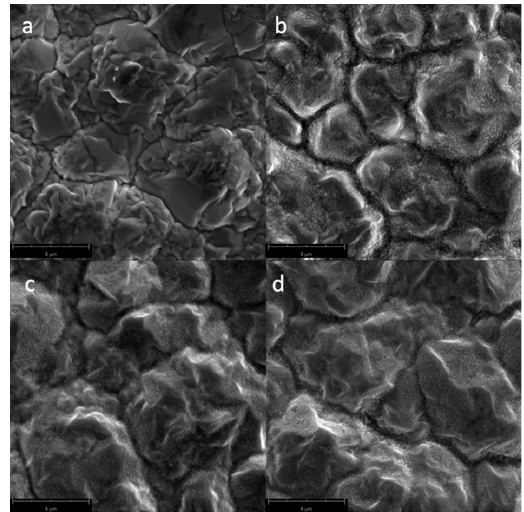
Figure 4. SEM micrographs of the surfaces of the Cu samples (magnified at 10,000 × ) subjected to oxygen plasma with varying O 2 gas flow rates: ( a ) untreated; ( b ) 10 sccm; ( c ) 15 sccm; and ( d ) 20 sccm.